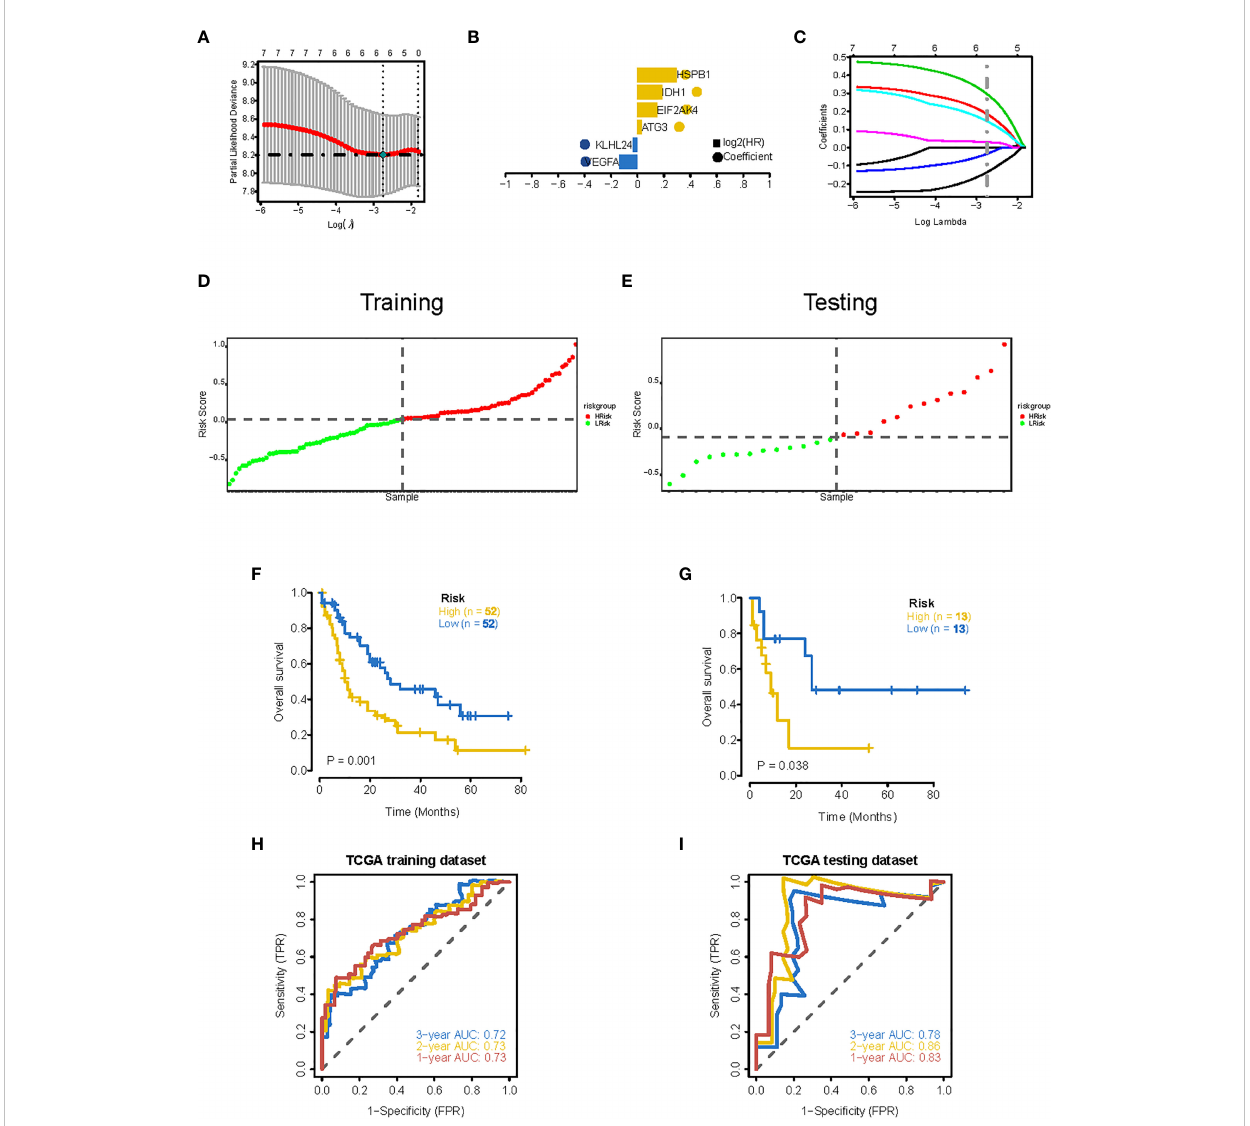
FIGURE 4 Construction of 6-gene prognostic signature. (A) Determination of the minimum lambda value with ten-fold cross validation of tuning parameter selection in the LASSO model. (B) Distribution of LASSO coef fi cients for prognosis-related genes and the gene combinations at the minimum lambda value. (C) Coef fi cients of Lasso genes. (D, E) The distribution of the risk scores in the training and testing datasets. (F, G) Survival curves of TCGA training dataset and testing dataset. (H, I) ROC curves of TCGA training dataset and testing dataset (AUC values at 1, 2 and 3 years in both the training and testing datasets were greater than